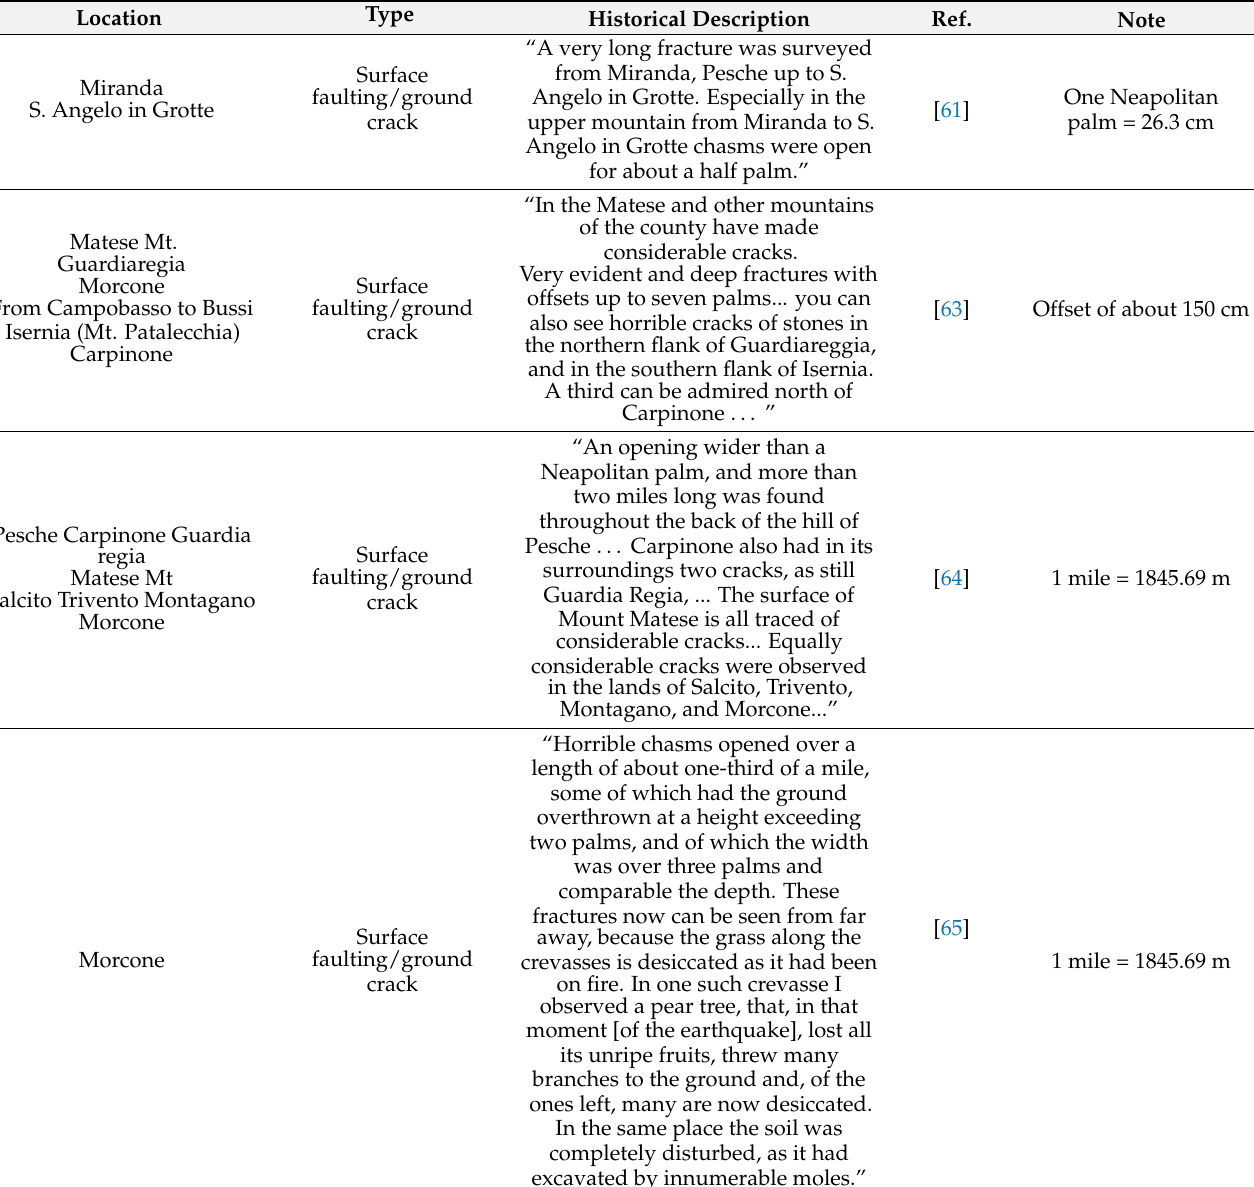
Table 1. The 26 July, 1805 earthquake-induced primary effects with contemporary descriptions of surface fault segments and ground cracks